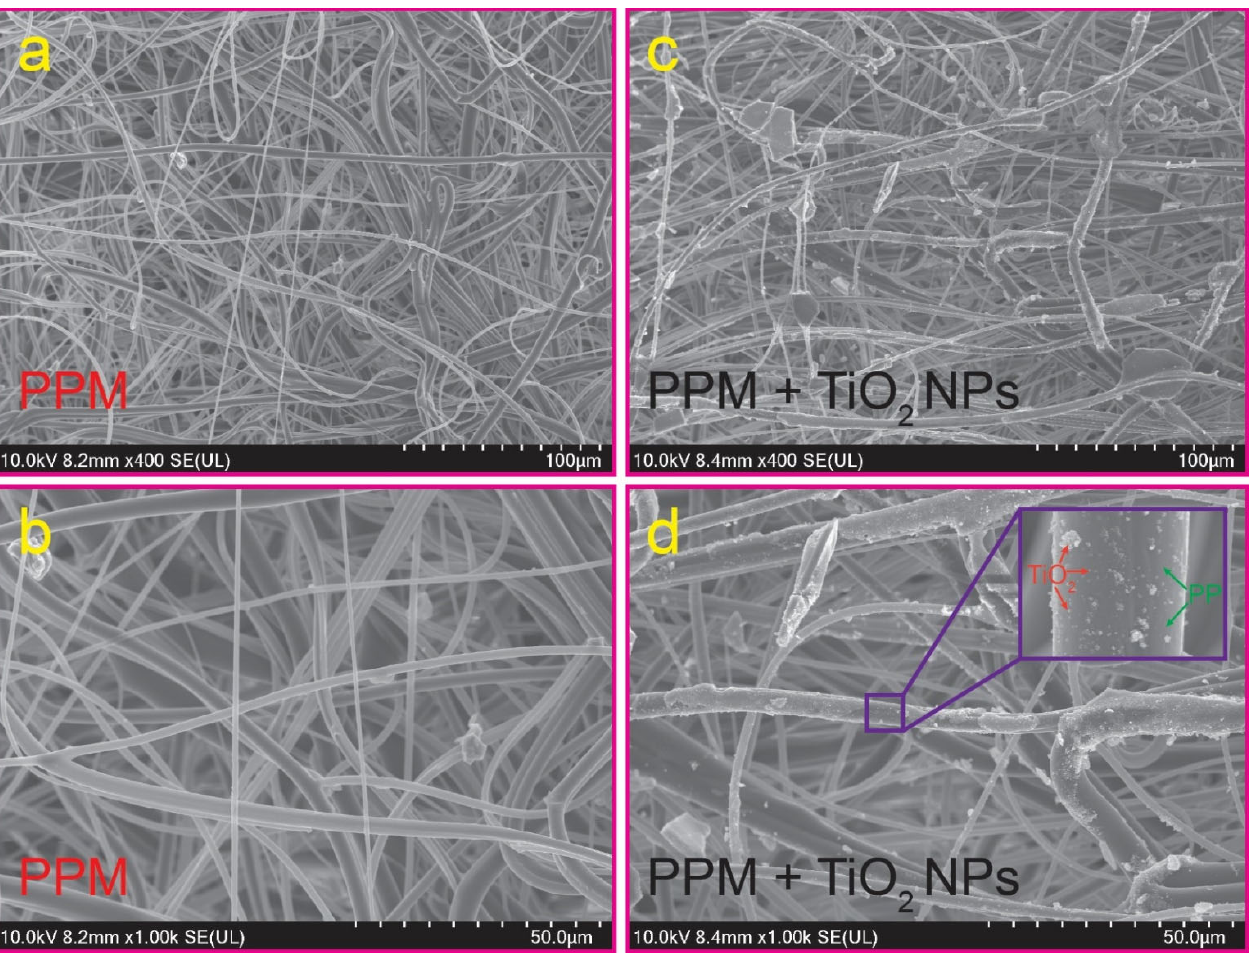
Figure 2. FE ‐ SEM photographs of the PPM ( a , b ) and PPM + TiO 2 NPs ( c , d ). Figure 2. FE-SEM photographs of the PPM ( a , b ) and PPM + TiO 2 NPs ( c , d ). Furthermore, a better understanding of the distribution and identity of elements in the as-prepared PPM + TiO 2 NPs was determined using EDS and elemental mapping analysis (Figure 3). The presence of three representative elements (C, Ti, and O) in the PPM + TiO 2 NPs and the absence of any other elements indicate that the PPM + TiO 2 NPs were created by the combination of only PPM and TiO 2 NPs. Additionally, the relative weights and atomic percentages of the constituents demonstrate that the TiO 2 NPs were successfully deposited onto the surface of the PPM (Figure 3a,b). The elemental mapping results show that the three elements were homogeneously distributed in the PPM + TiO 2 NPs system (Figure